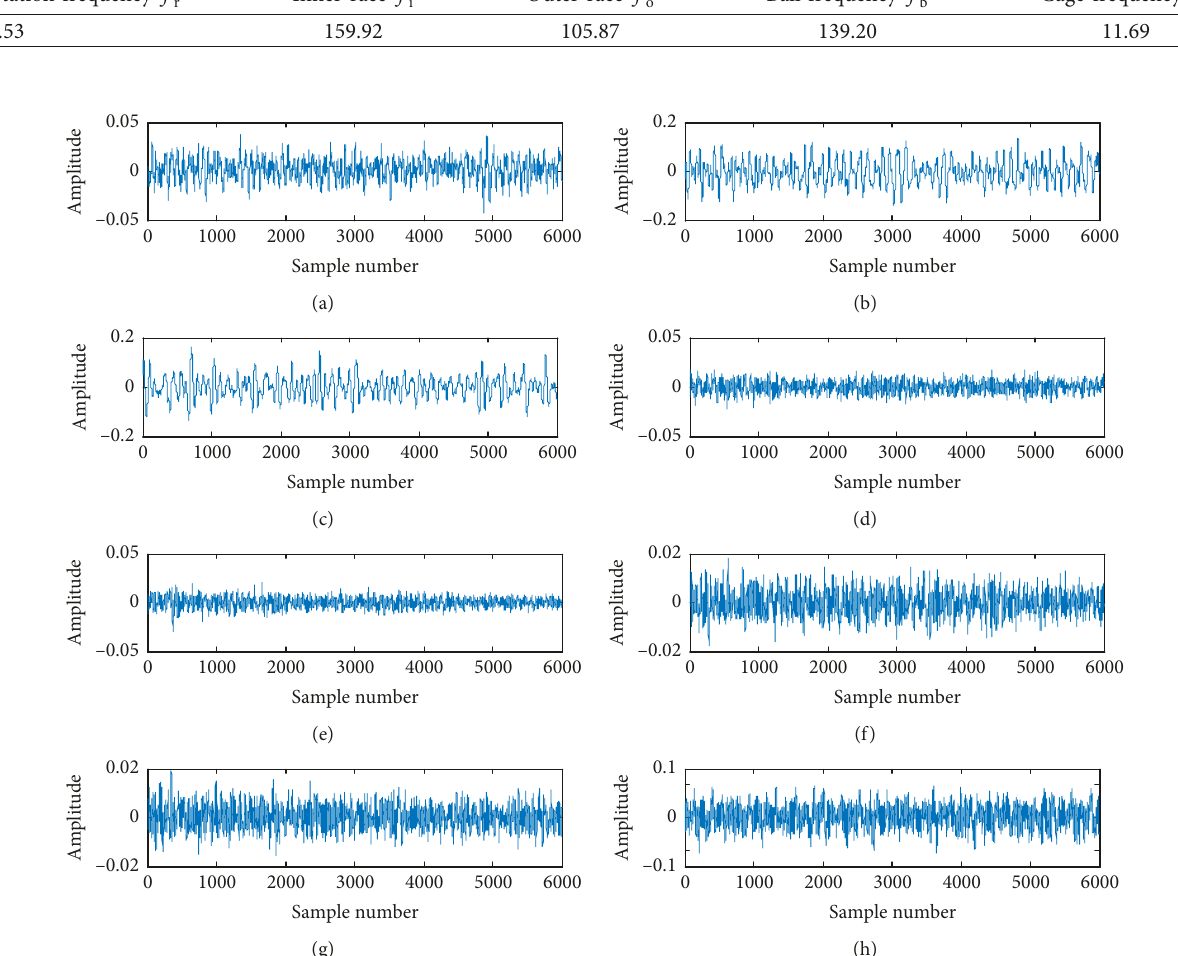
Figure 6: Multiresolution DMD modes of a normal roller bearing signal. Here, we select the first column of X layer slow or fast modes. (a)–(h) represent the modes of X symbols in the Figures 8–10 share the same